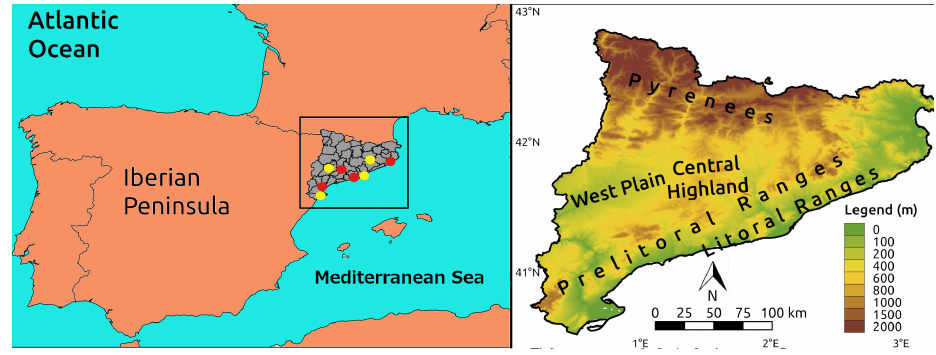
Figure 1. ( Left ) Map of the area of analysis marked by the black rectangle. The red dots indicate the positions of the weather radars, while yellow dots mark locations of lightning location sensors. ( Right ) The main topographic factors of the